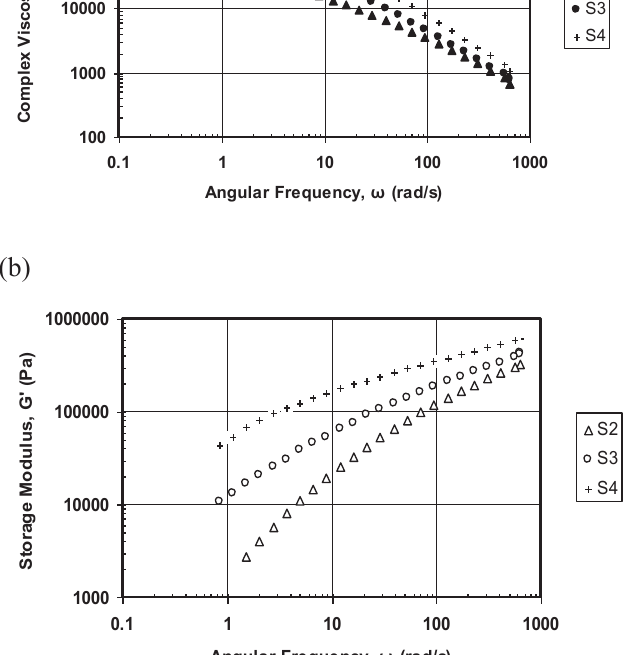
Fig. 3. (a) Complex viscosity (η*) and (b) storage modulus (G’) vs. angular frequency (ω) for samples S 2, S3 and S4 at temperature 26 0°C.